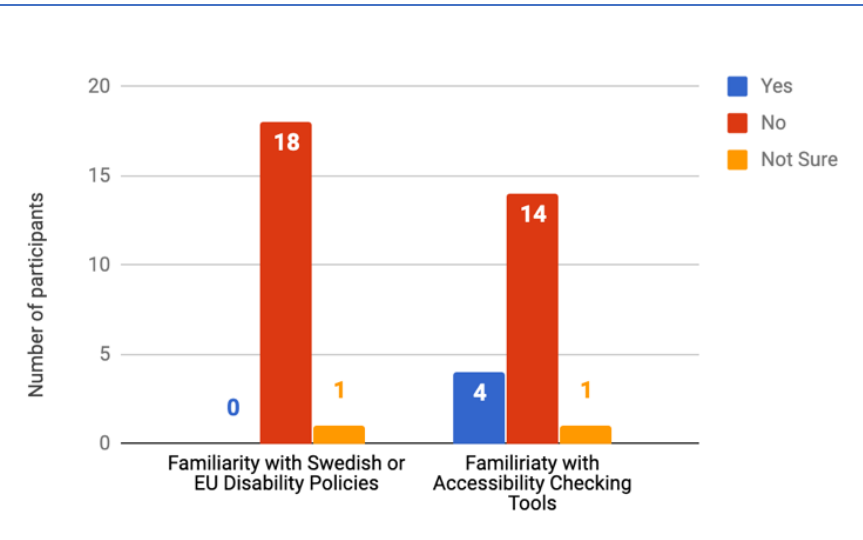
Figure 5. Familiarity with disability policies and accessibility software.